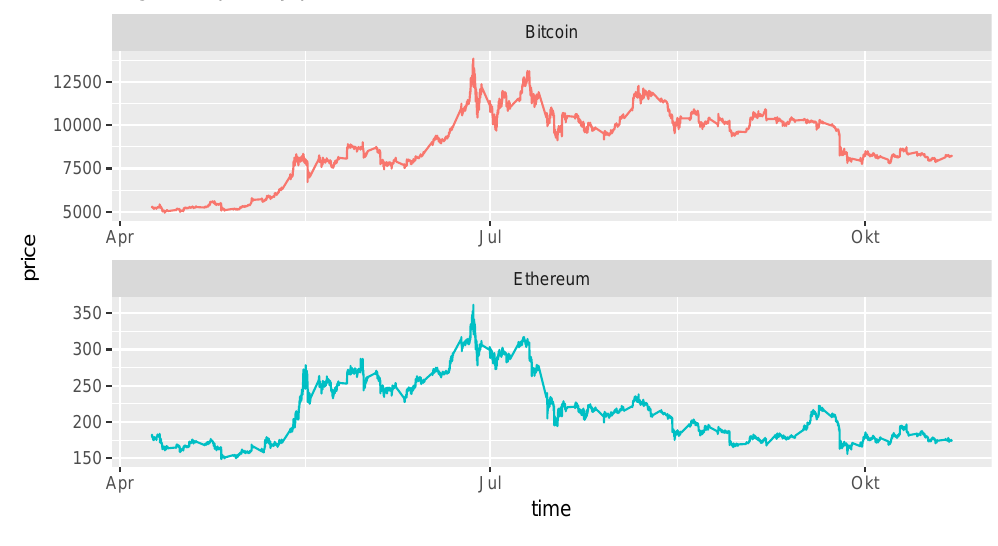
Figure 6: Time series of Bitcoin and Ethereum HF prices